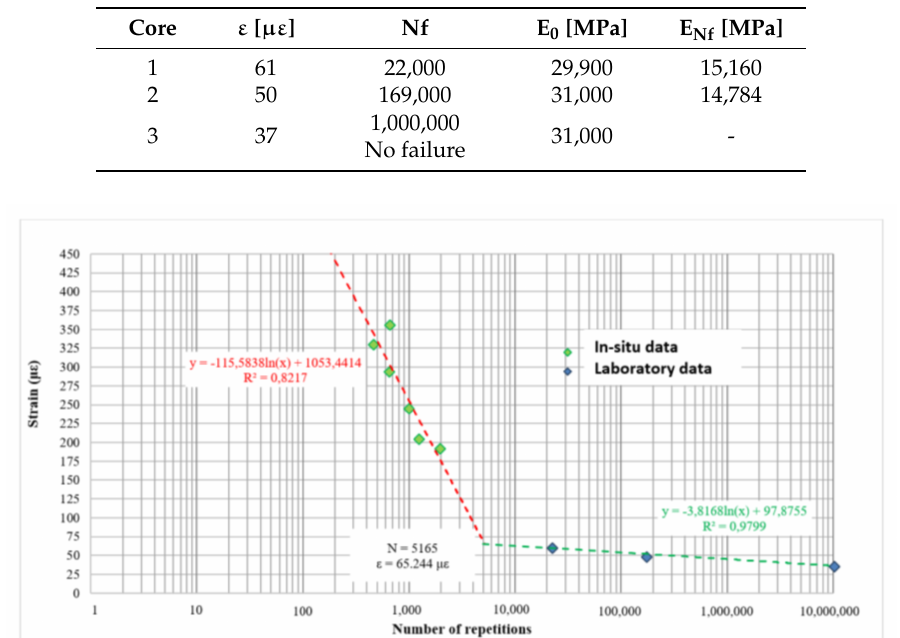
Figure 10. RTM performance